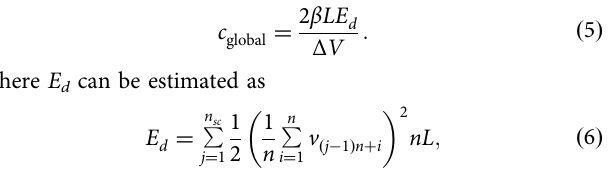
Fig. 5 Tuning nonreciprocity and wave speed. a Snapping times for transition waves propagating both left-to-right and right-to-left in chains comprising N = 48, 49, and 50 elastically and plastically deformed arches periodically arranged according to the pattern shown in Fig. 4b. Note that for N = 49 the arches do not snap in sequence when excited right-to-left (the blue dot representing the snapping time for the 49-th arch is t snap the transition waves along the chain for different patterns of elastically/plastically deformed arches. The dashed lines correspond to the predictions of Eqs. (5 – 7). (i) Chain with all plastic arches, (ii) chain with one plastic and one elastic arches, (iii) chain with one plastic and two elastic arches, (iv) chain with one plastic and three elastic arches, (v) chain with one plastic and four elastic